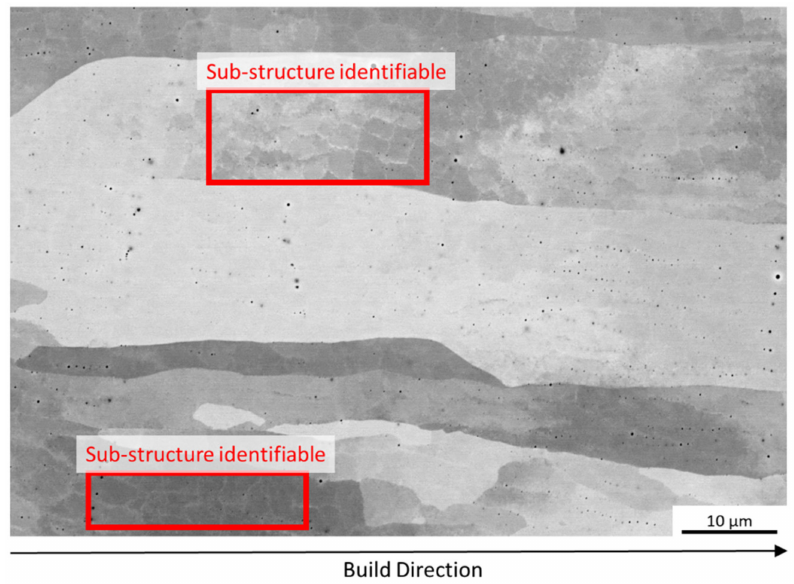
Figure 4. SEM Image of microstructure of cube (E A 4.5 J/mm 2 ) with relative density >99.5%, sub-grain structure can clearly be